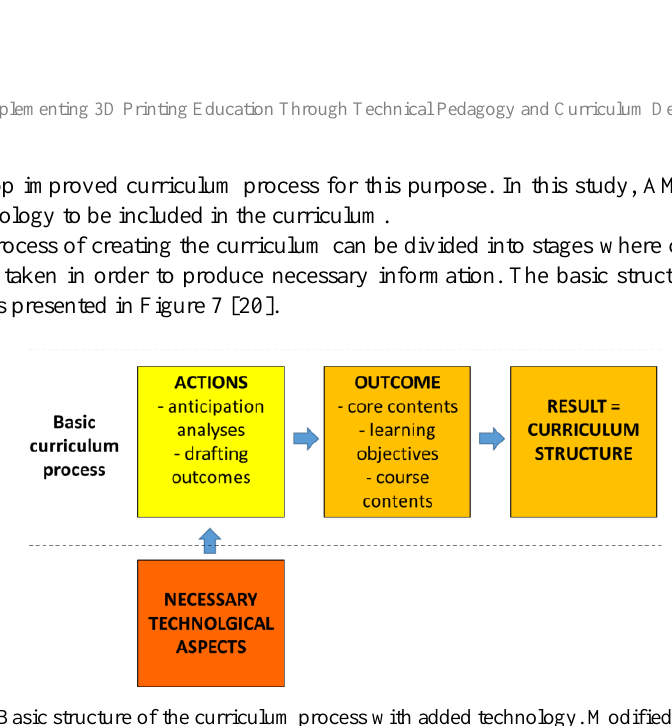
Fig. 7. Basic structure of the curriculum process with added technology. Modified from the Lapland UAS curriculum process